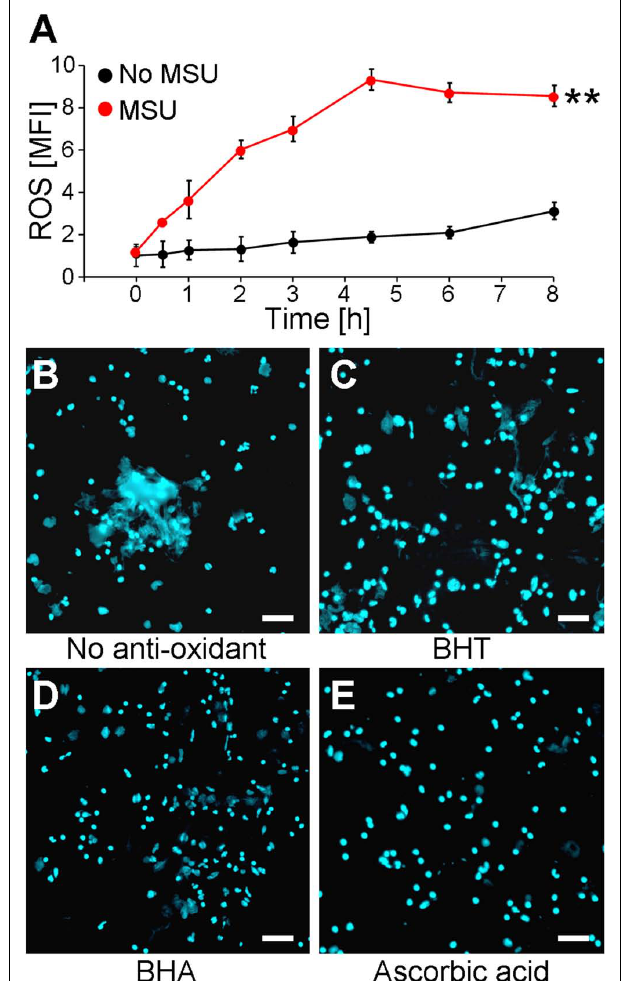
FIGURE 1 | MSU-induced NET formation depends on oxidative stress (ROS). (A) Whole blood was treated with or without MSU ( n = 3 per group) and analyzed for ROS production by cytofluorometry. MSU crystals induce oxidative stress (ROS) in neutrophils. ** P < 0.01. (B–E) Whole blood was incubated with MSU in the absence (B) or the presence of BHT (C), BHA (D) , or ascorbic acid (E) . Cytospins were stained for extranuclear DNA. NET formation by neutrophils after incubation with MSU was inhibited by the anti-oxidants BHT (C) , BHA (D) , and ascorbic acid (E) . All experiments were performed at least three times. Scale bars, 100 μ